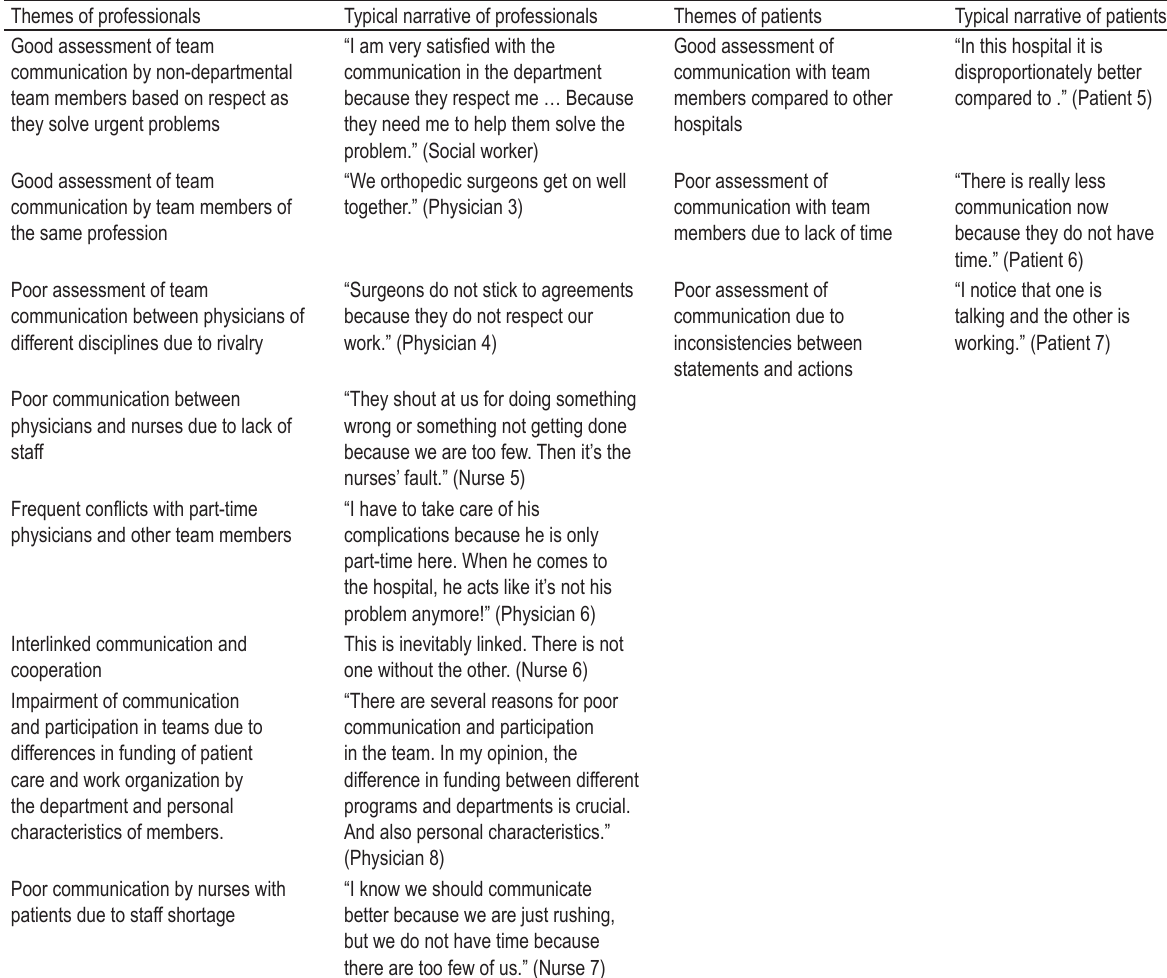
TABLE 6. Key themes from professionals and patients Themes of professionals Typical narrative of professionals Themes of patients Typical narrative of